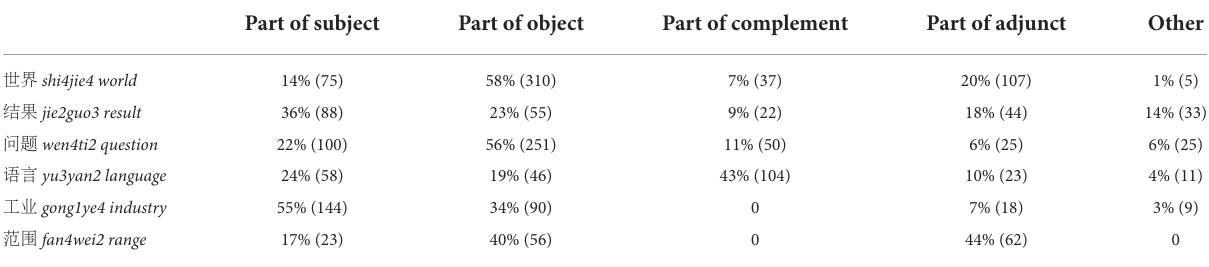
TABLE 12 A comparison of the grammatical distribution of 世 界 shi4jie4 in the clause with that of other nouns in the LCMC. Part of subject Part of object Part of complement Part of adjunct